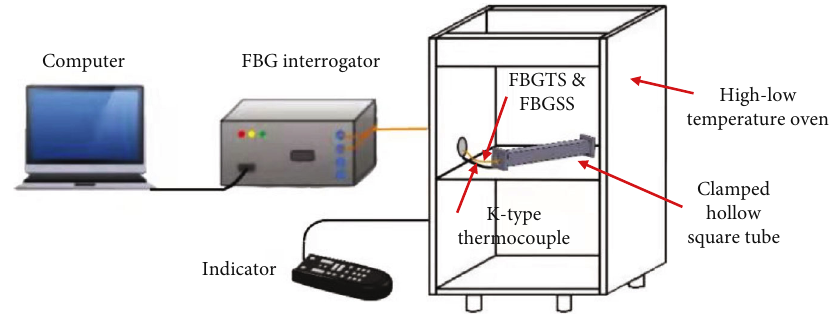
Figure 5: Experimental setup for the hybrid HST with sandwich